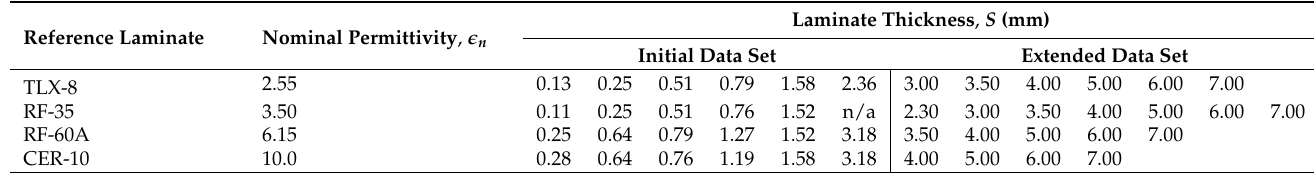
Table 3. The reference data set extended by additional thickness points.